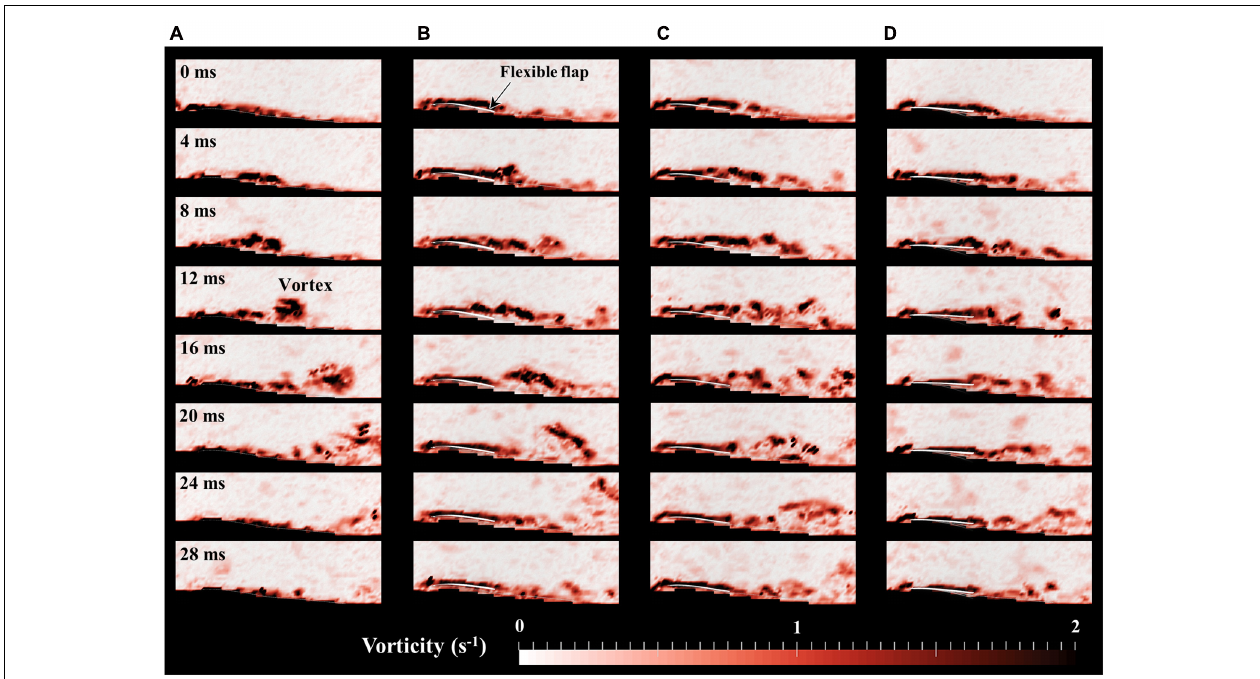
FIGURE 6 | Time-series of the vorticity field within 28 ms around (A) basic wing, (B) model-30, (C) model-50, and (D) model-80 at disturbance frequency of 6 Hz. The ratio of high vorticity area is minimized when t = 0 ms in each